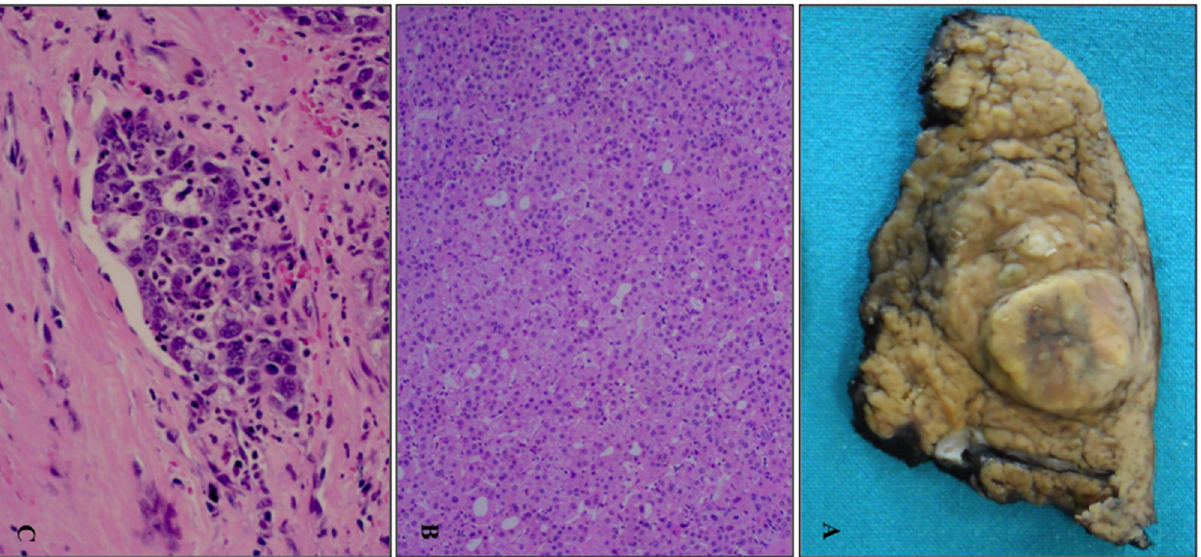
Figure 1. Gross and microscopic features of HCC. Surgical sample of hepatocellular carcinoma developed in a cirrhotic liver (A). Histological sample of hepatocellular carcinoma (10x, H&E) (B). Neoplastic embolus of a poorly differentiated hepatocellular carcinoma (20x, H&E)